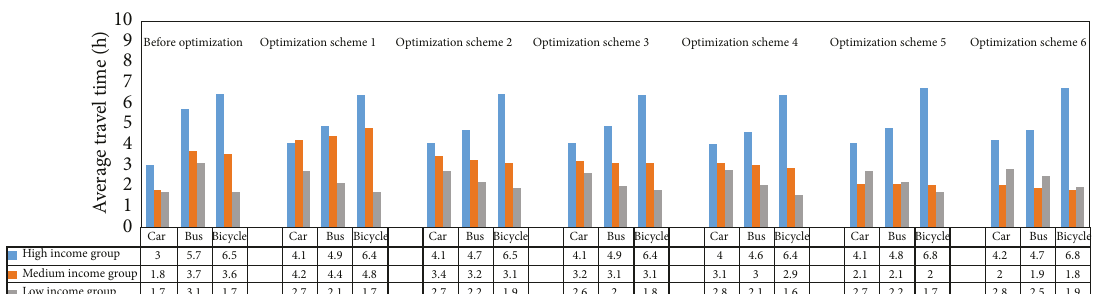
Figure 6: Compared the different traffic mode travel